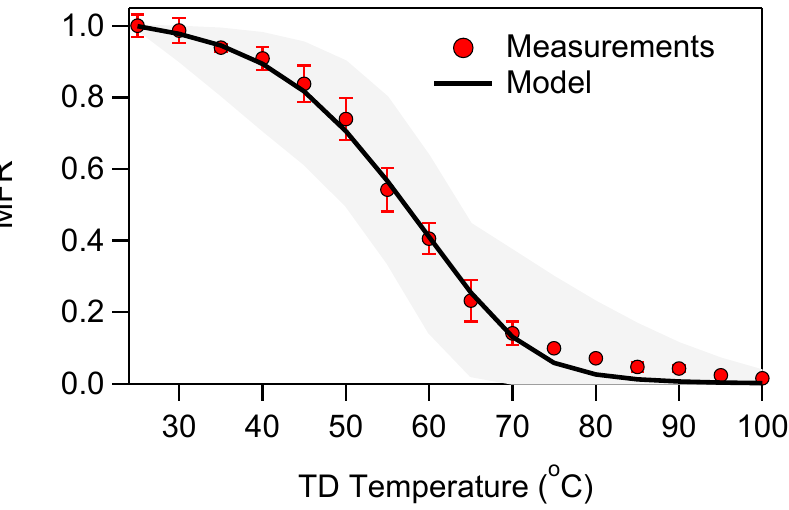
Figure 2. Mass fraction remaining (MFR) after the TD based on AMS measurements. All values have been corrected for size temperature dependent particle losses. The error bars correspond to one standard deviation. The modeled MRF has been calculated using the centerline residence time. The shadow area represents the minimum and the maximum MFRs of the solutions within 2% of the best solution.